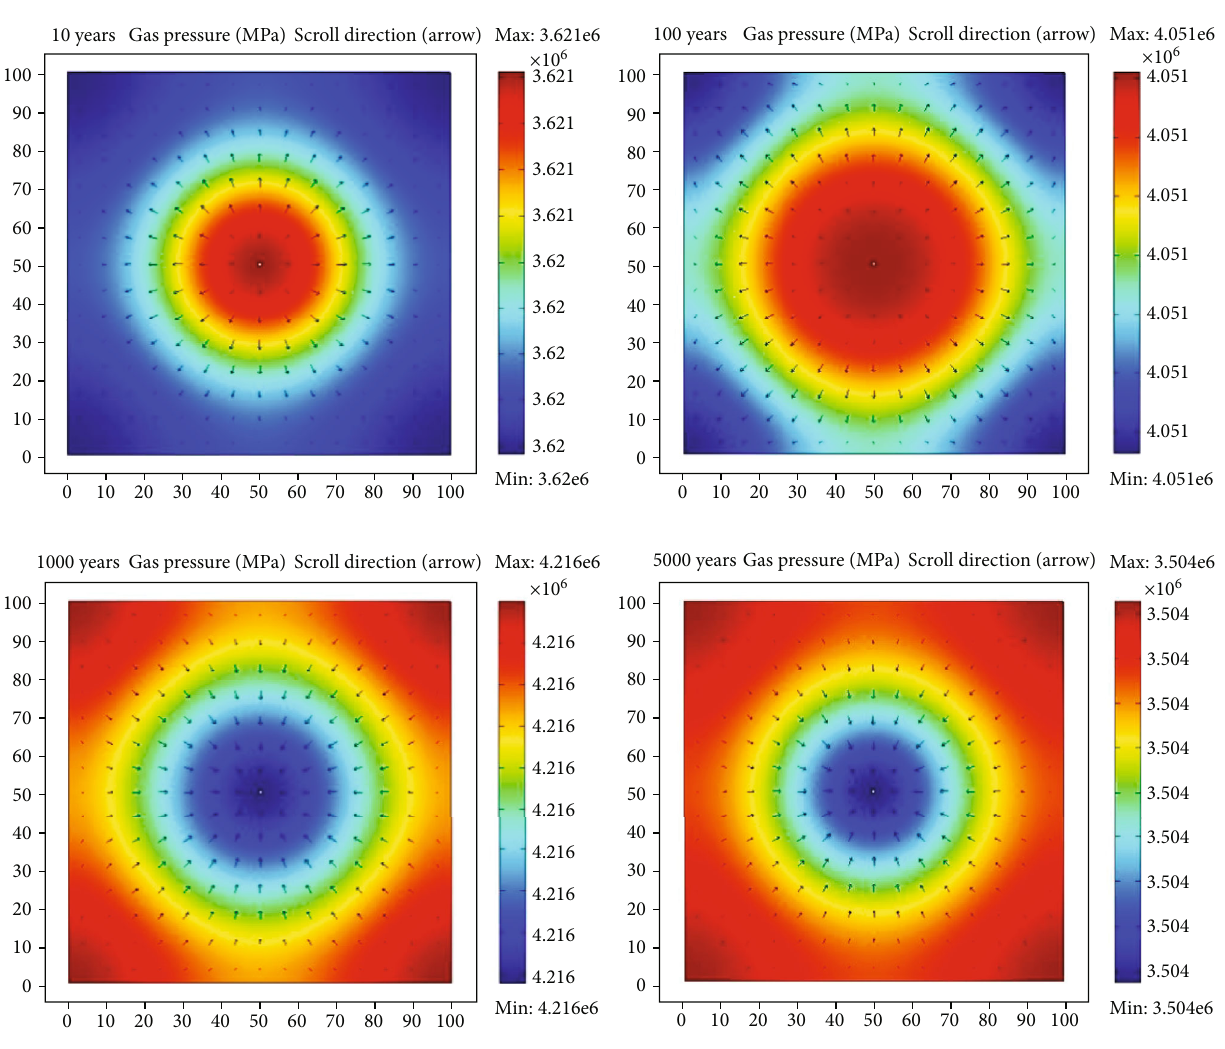
Figure 6: Distribution of gas